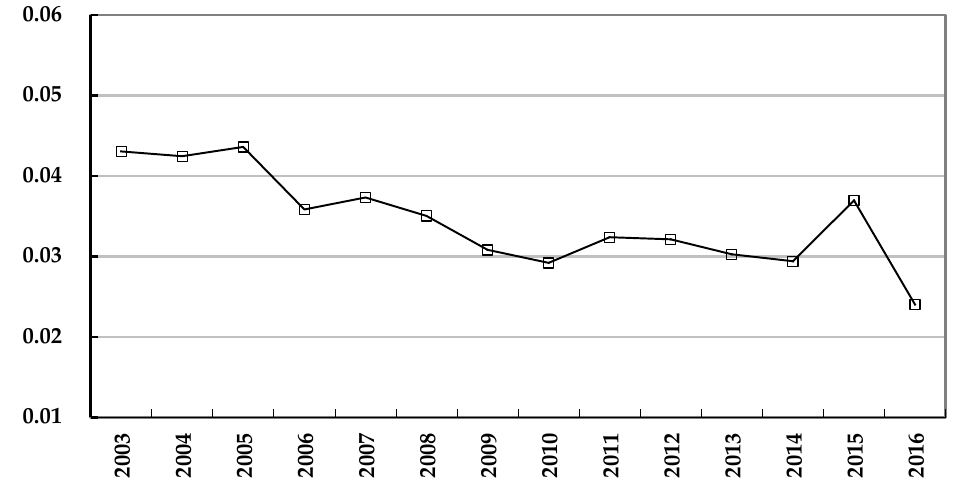
Figure 1. Theil index of provincial efficiency difference of Chinese township hospitals.